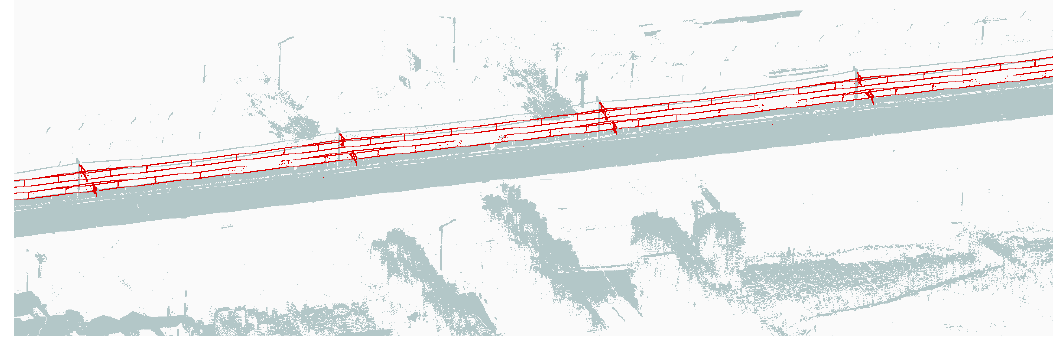
Figure 5. The OCS extraction point cloud result by preprocessing (red is the OCS extraction result, gray is the background point).